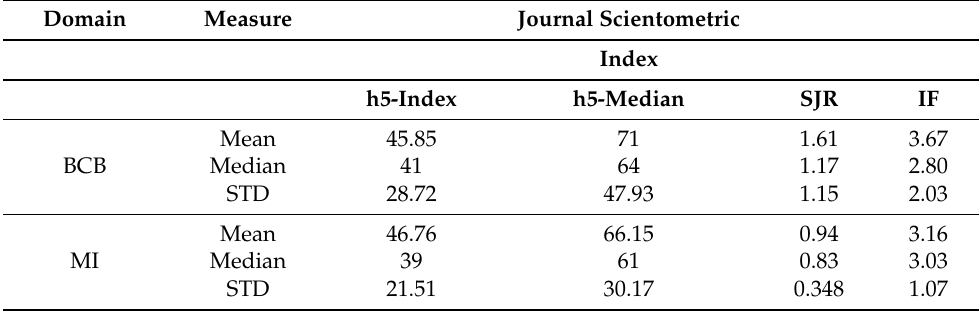
Table 1. Various statistics of the scientometric indices of top BCB and MI journals.